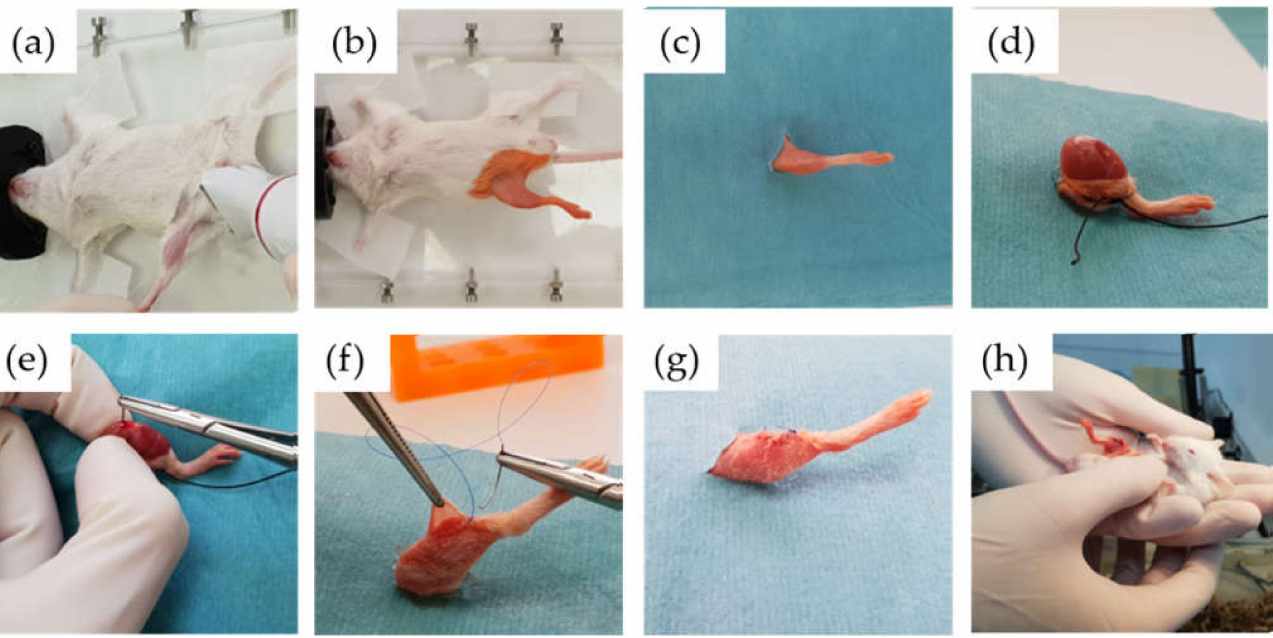
Figure 9. Surgical procedure: inhaled anaesthesia and shaving of the limb ( a ), antiseptic washing and isolation of the surgical field ( b , c ), skin dissection and exposure of the bony entry point ( d ), retrograde introduction of the biomaterial into the femur of the mouse ( e ), suture and cleaning of the surgical wound ( f , g ), awakening and care of the animal ( h